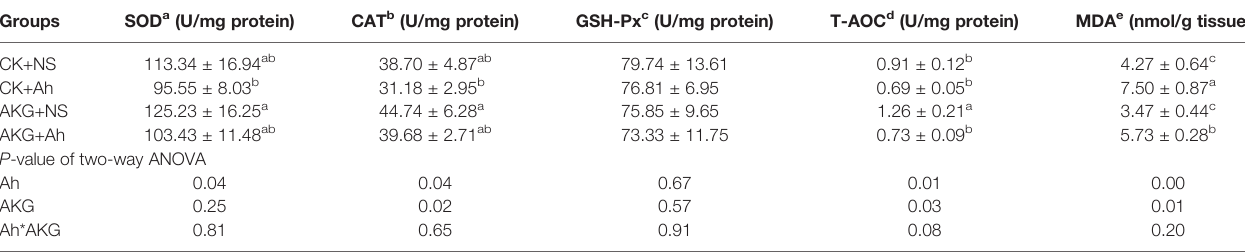
All of the values are expressed as the means ± SEM, and different superscript letters in the same column are signi fi cantly different (P < 0.05). a SOD, superoxide